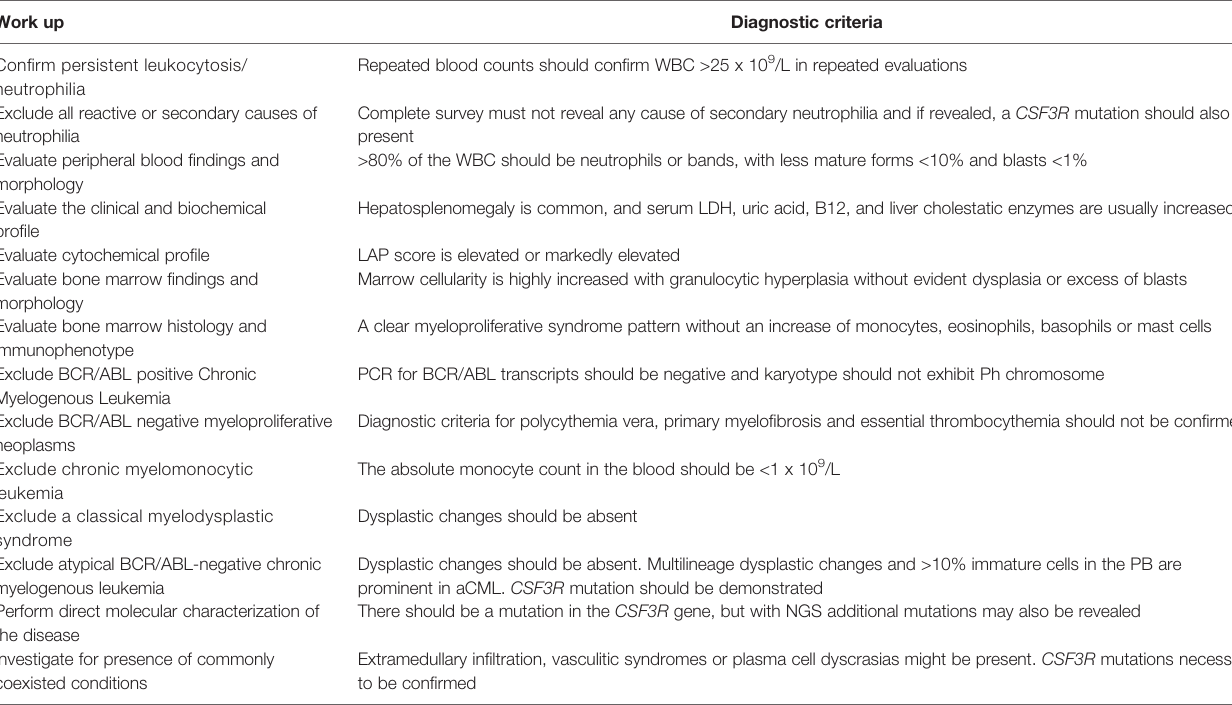
TABLE 1 | Diagnostic work up and diagnostic criteria for